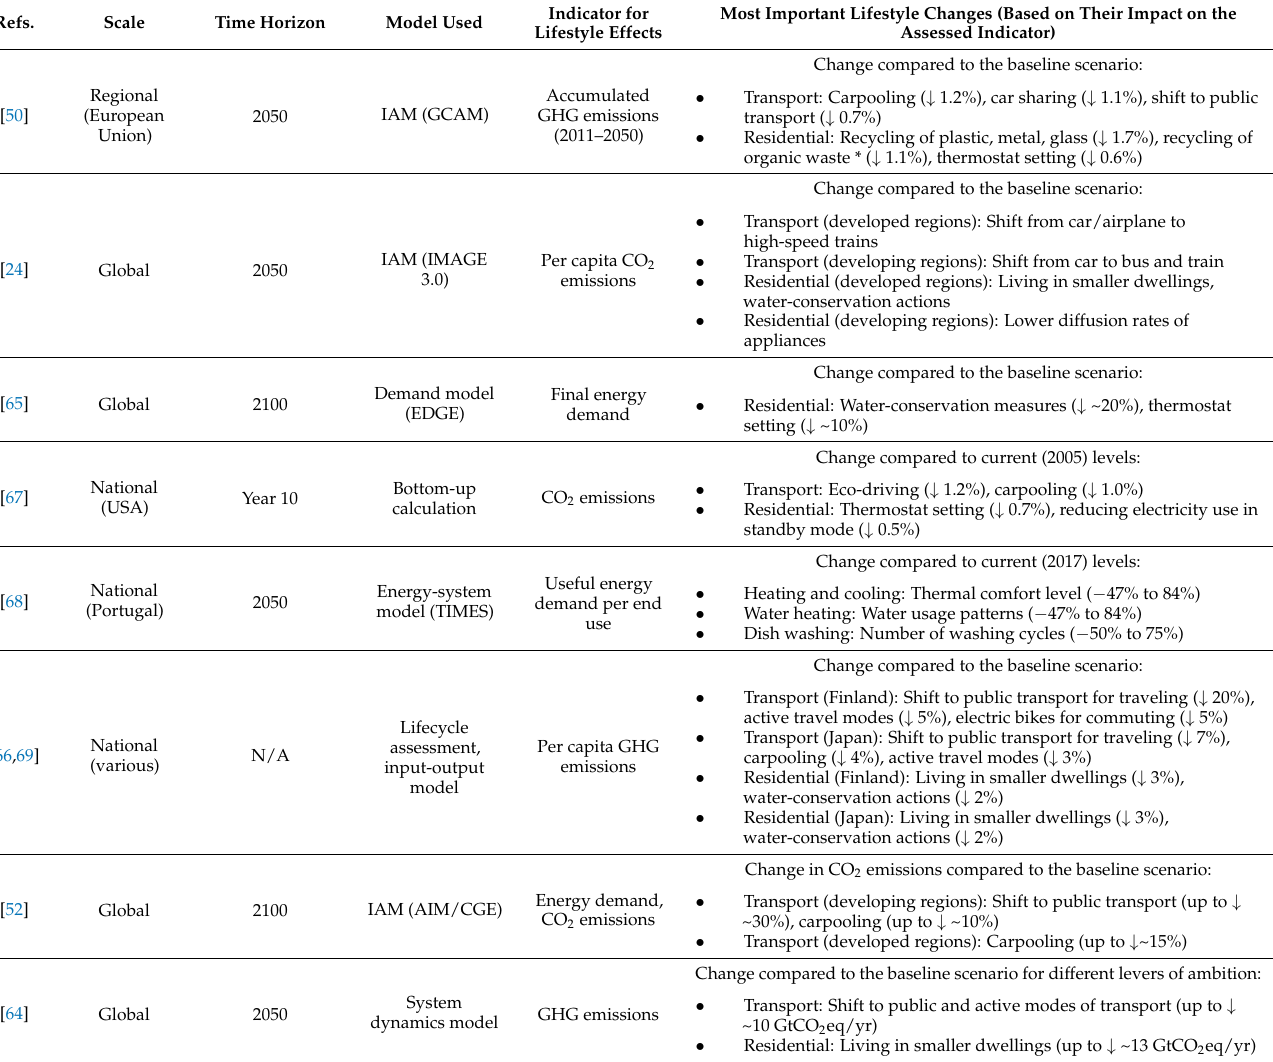
Table 2. List of studies with an assessment of the relative importance of individual lifestyle changes.